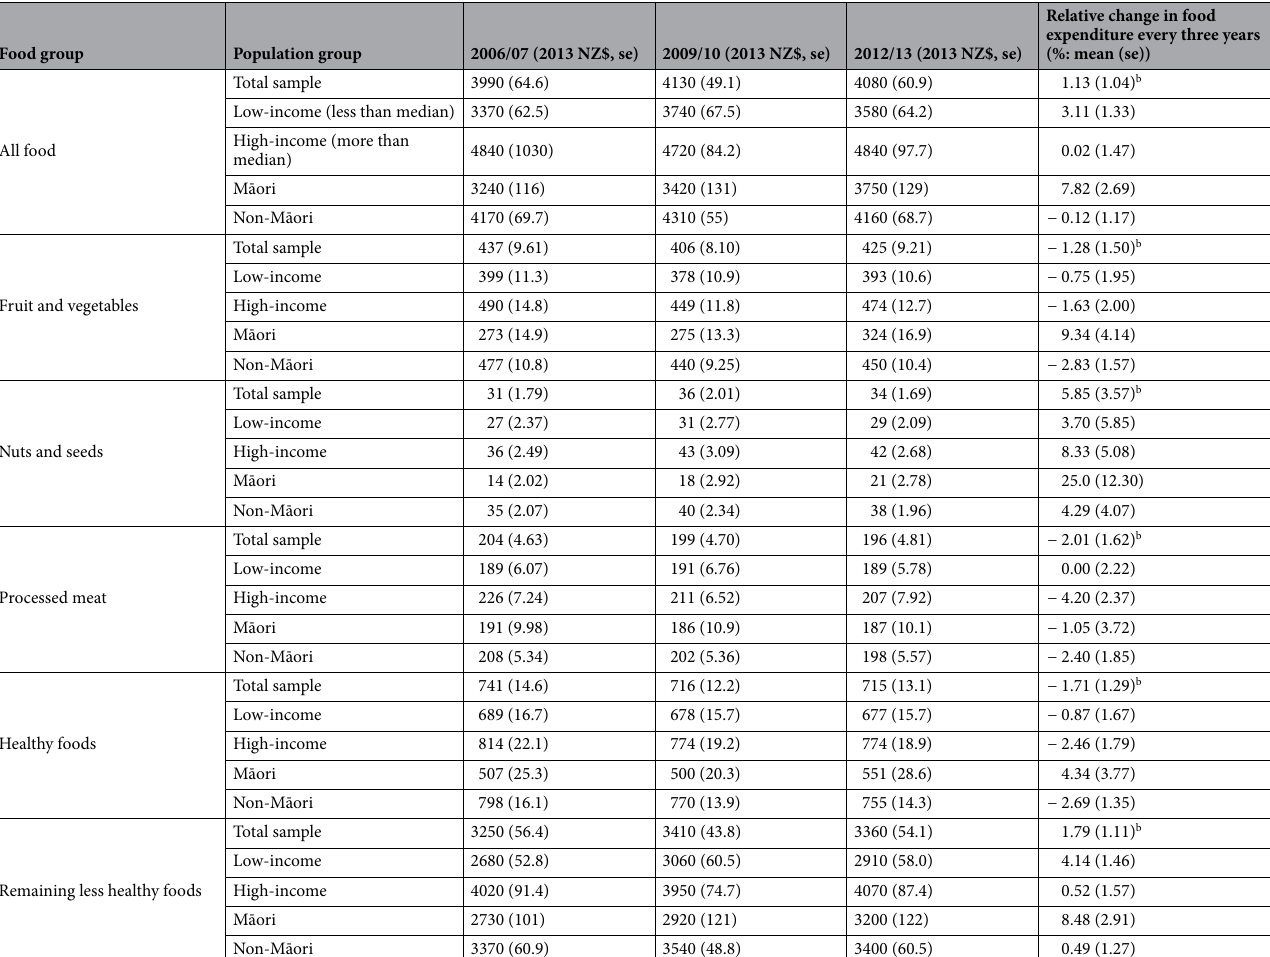
Table 2. Annual expenditure per capita (in 2013 NZ$) by food group, income-level and ethnicity in three HES waves: 2006/07, 2009/10, and 2013/13 a . a Numbers may not add up exactly as they were randomly rounded to meet confidentiality requirements. b Values in this column were derived using linear regressions with the survey year as the only independent variable, but no changes were statistically significant. All values in this table were calculated or estimated using survey